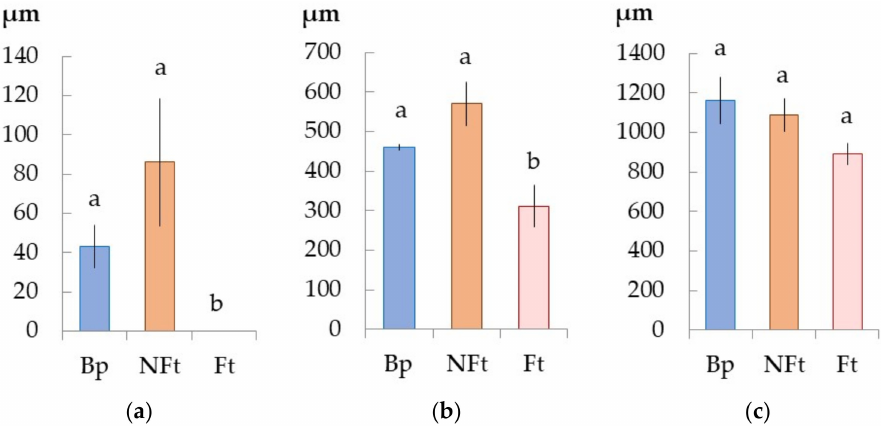
Figure 2. The current year xylem growth ring width of B. pendula var. pendula (Bp), non-figured (NFt), and figured (Ft) B. pendula var. carelica trees. Samples were collected on 28 May 2020 ( a ), 11 June 2020 ( b ), and 25 June 2020 ( c ). n = 9.